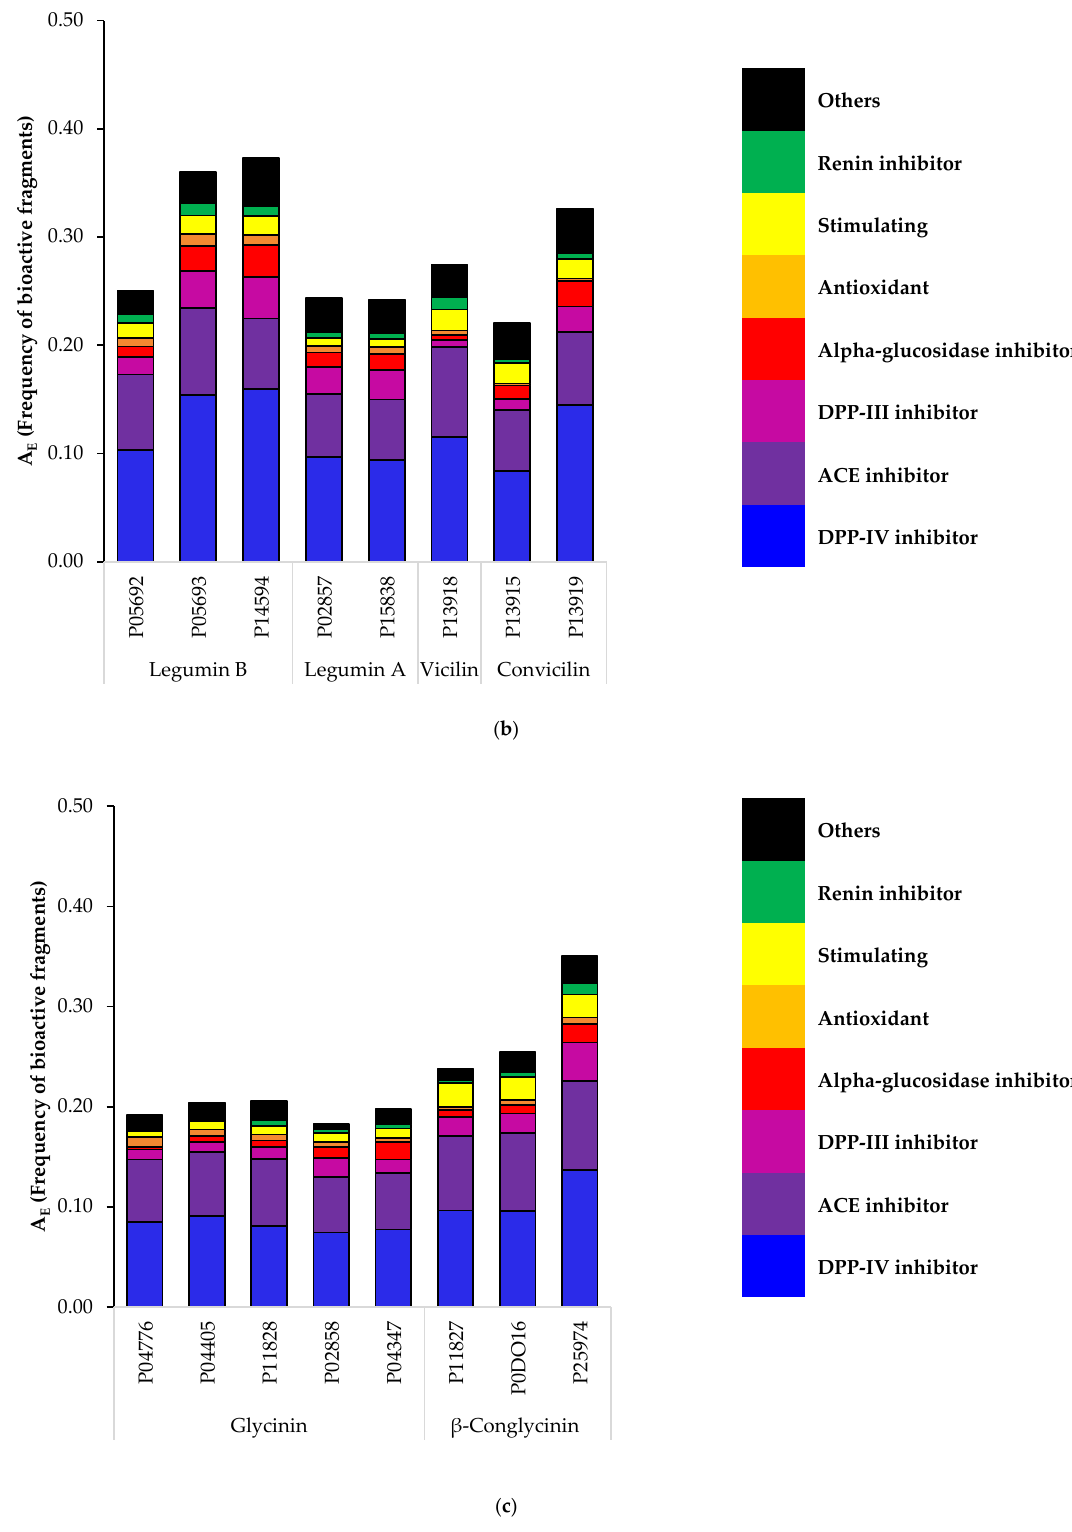
Figure 3. In silico prediction of bioactive fragments released during gastrointestinal digestion of ( a ) faba bean; ( b ) pea; ( c ) and soy main storage